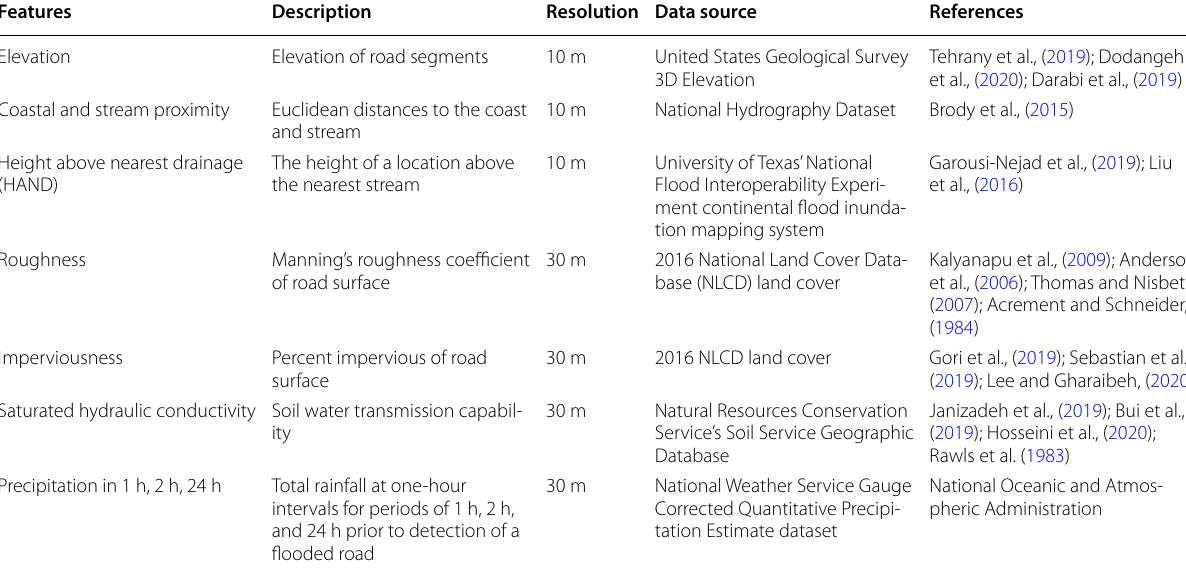
Table 1 Summary of input features